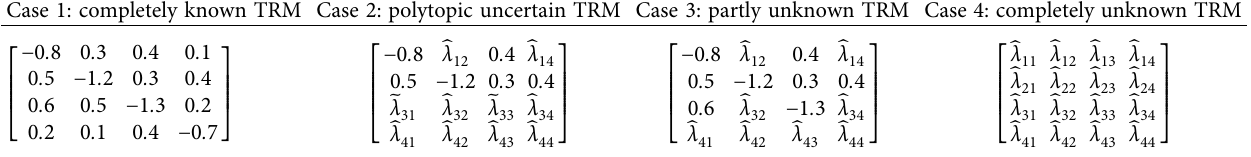
Table 1: TRMs of four different cases.